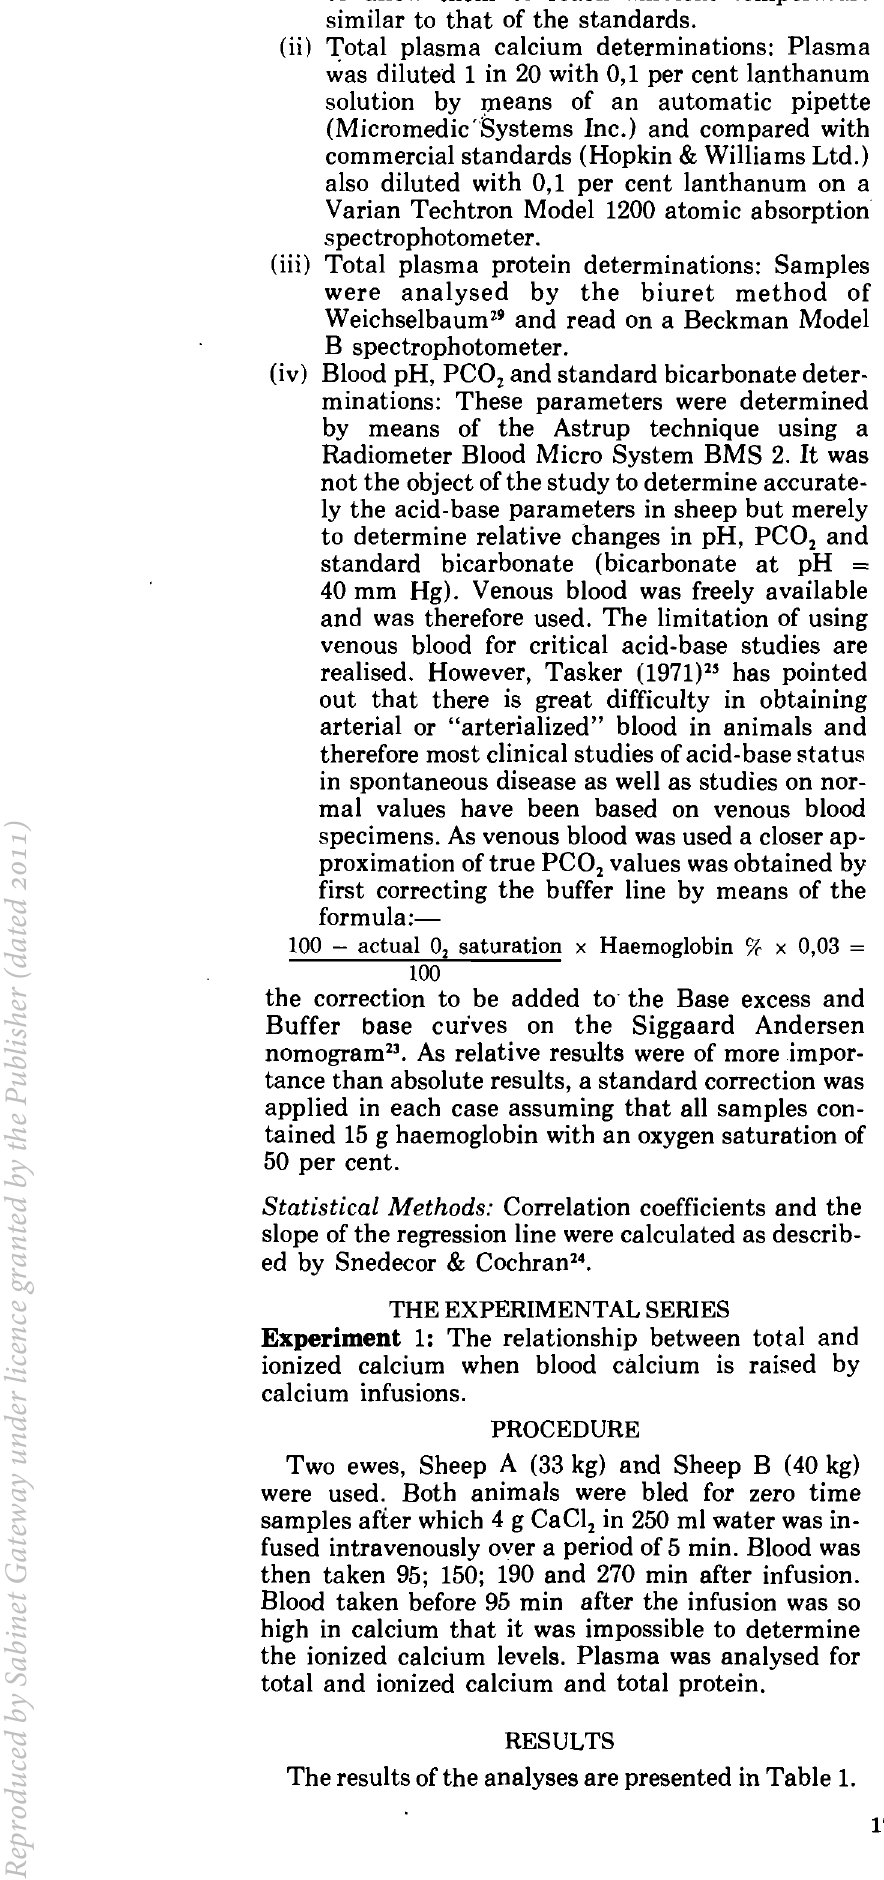
Table 1 : THE EFFECT OF INTRAVENOUS INFUSIONS OF 4g CaCI 2 1NTO SHEEP ON PLASMA TOTAL CALCIUM, IONIZED CALCIUM AND TOTAL PROTEIN Sheep